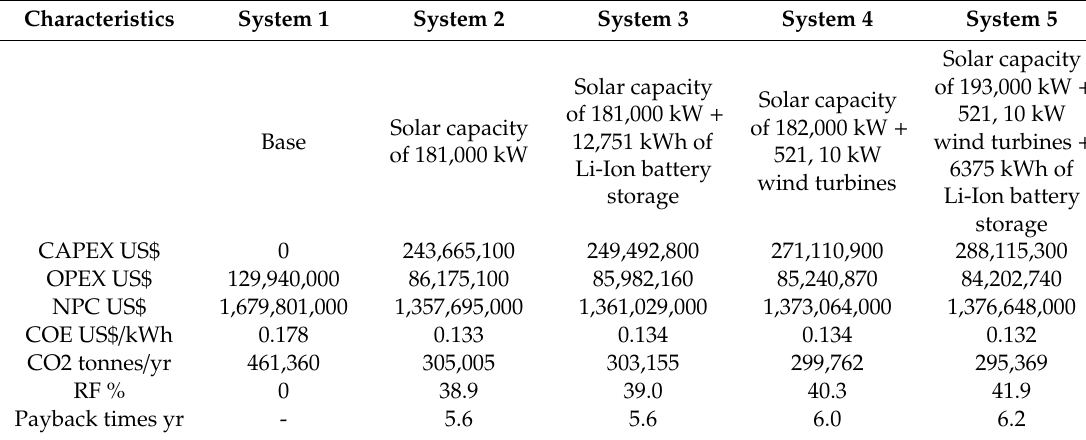
Table 3. Scenarios of the developed model for Zagazig.